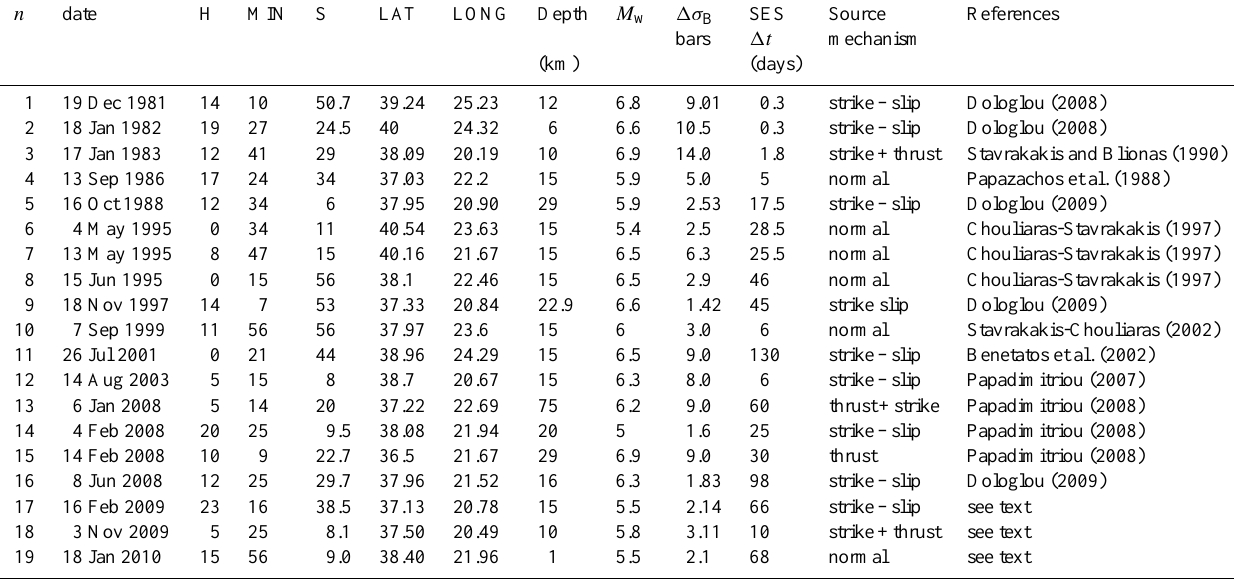
Table 1. The updated version of the table reported by Dologlou (2009) including 3 new earthquakes in Ionian Sea and Central Greece (events no. 17, 18, and 19). All 19earthquakes are presented with available stress drop values and precursory SES signals in Greece from 1981 to 2010, along with their dates, epicentres, depths, moment magnitudes M w , stress drop values ( 1σ B ), SES lead times 1t and mechanism type (strike-slip, normal or thrust). Events are numbered in chronological order and references for the stress drop values are given in the last column.